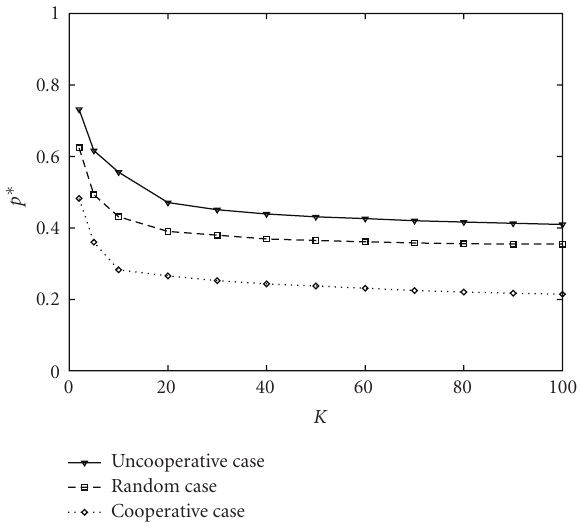
Figure 11: File availability p ∗ as a function of K (scale-free network with m = 2, threshold assignment